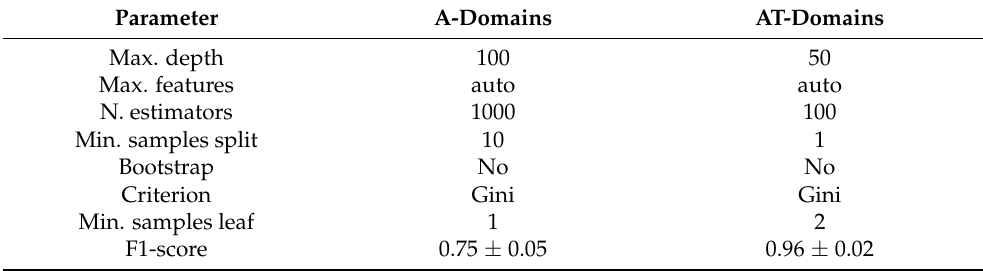
Table 3. Best grid search parameters for the RF models for AT- and A-domain specificity classification. The error for the micro F1-score is based on the standard deviation over all cross-validation queries. Parameter A-Domains AT-Domains Max. depth 100 50 Max. features auto